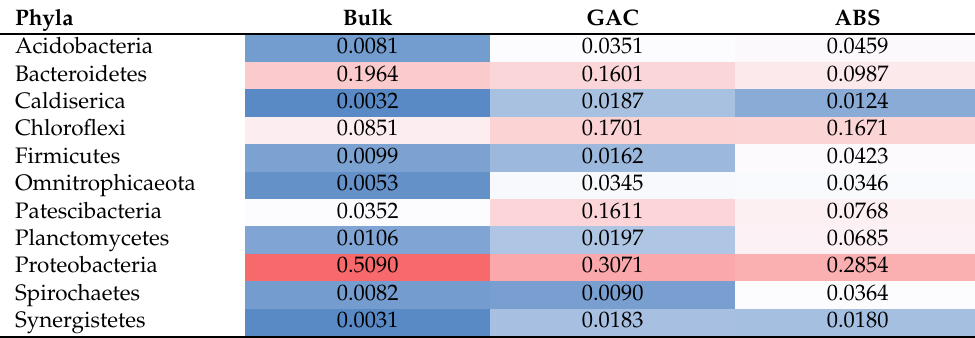
Figure 5. Principal coordinate analysis (PCoA) performed on microbial community structure dissimilarity. A weighted UniFrac distance metric was used to evaluate the compositional difference with the account of the relative abundance distribution. Samples were colored by their sample type. The size of the node was based on the value of the Shannon diversity index, which measures the richness and evenness of the microbial community. Panel ( a ) shows the result of the bacterial communities; panel ( b ) shows the results of the archaeal communities. Table 4. A heat map of bacterial composition at the phylum level (relative abundance > 1%).